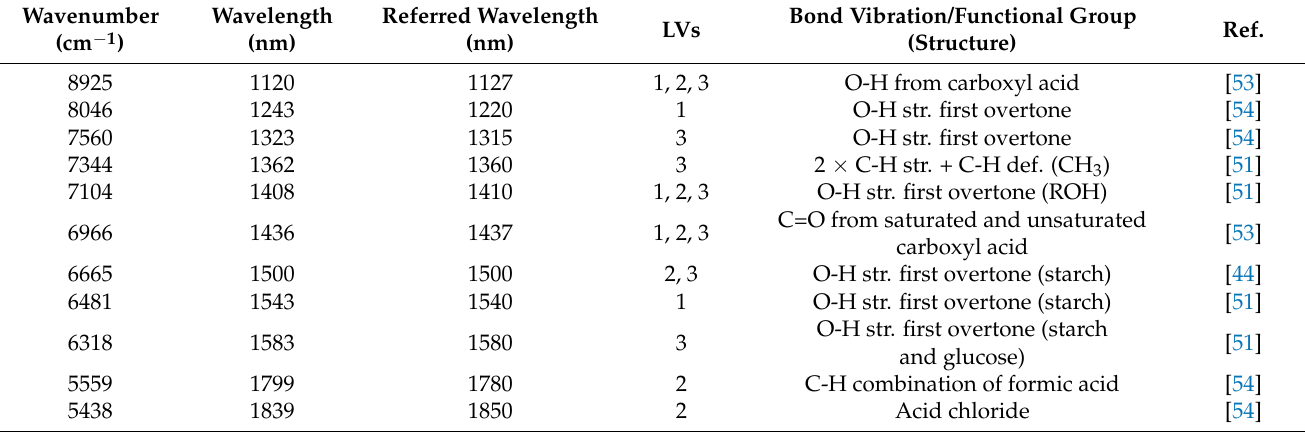
(Figure 8). Similarly, in the X-loading weight plot (Figure 9), peaks related to water at 1450 nm, starch and glucose at 1580 nm, and carbohydrate at 2200 nm [44] were seen, which were the important peaks for the TSS prediction in the mangosteen pur é e. Table 11. The bands with a high X-loading weight of the PLSR model for TA in mango pur é e.